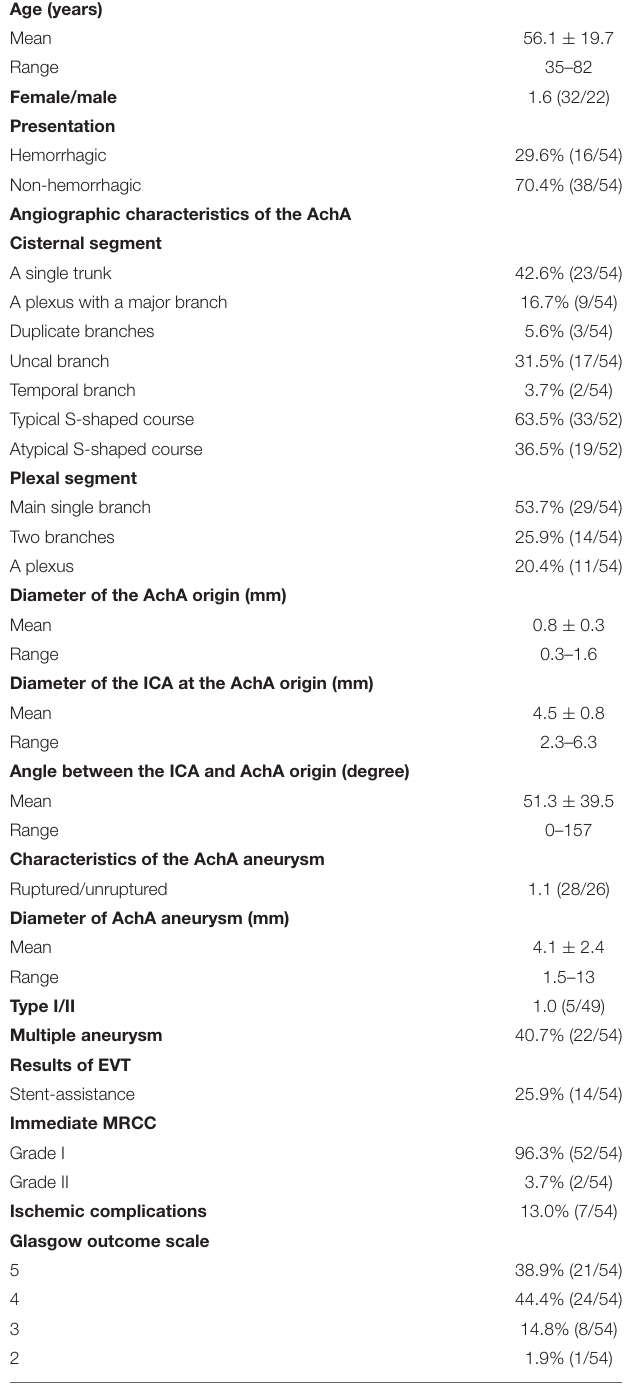
TABLE 1 | Main clinical data of the patients in the present